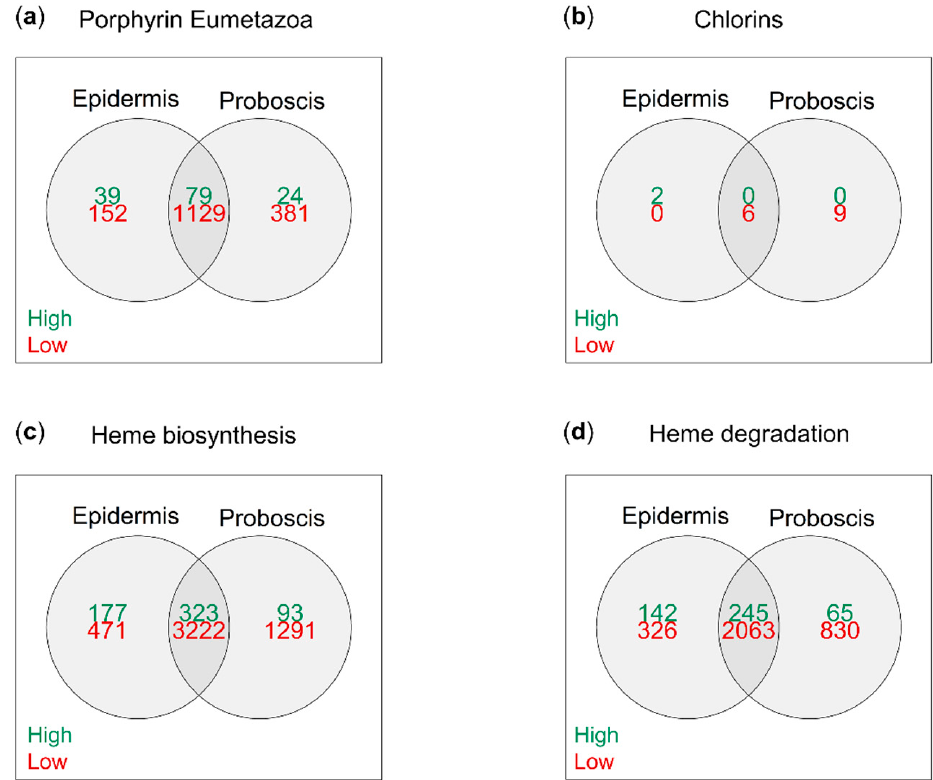
Figure 4. Relative expression of total tetrapyrrole/porphyrinoid-related ORFs in Eulalia obtained via RNA-seq and de novo transcriptome assembly. Each Venn diagram represents a customized subset of the Uniprot database built from specific search terms. ( a ) “Porphyrin Eumetazoa”, ( b ) “chlorins”, ( c ) “heme biosynthesis”, and ( d ) “heme degradation”. Relative expression was arbitrarily identified as “high” and “low” when logTPM > 2 and logTPM < − 2, respectively.